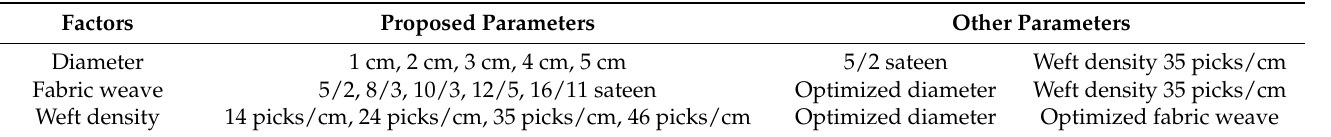
Table 1. Parameters of fabric electrode for each factor.